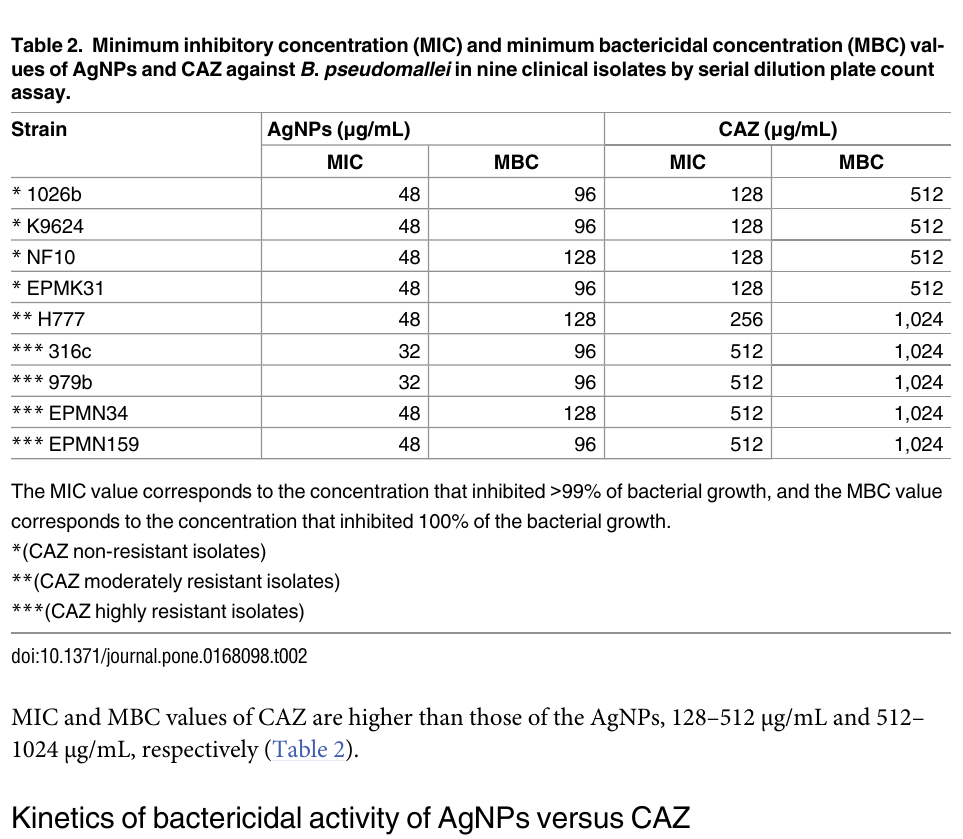
Table 2. Minimum inhibitory concentration (MIC) and minimum bactericidal concentration (MBC) val- ues of AgNPs and CAZ against B . pseudomallei in nine clinical isolates by serial dilution plate count assay. Strain AgNPs ( μ g/mL)